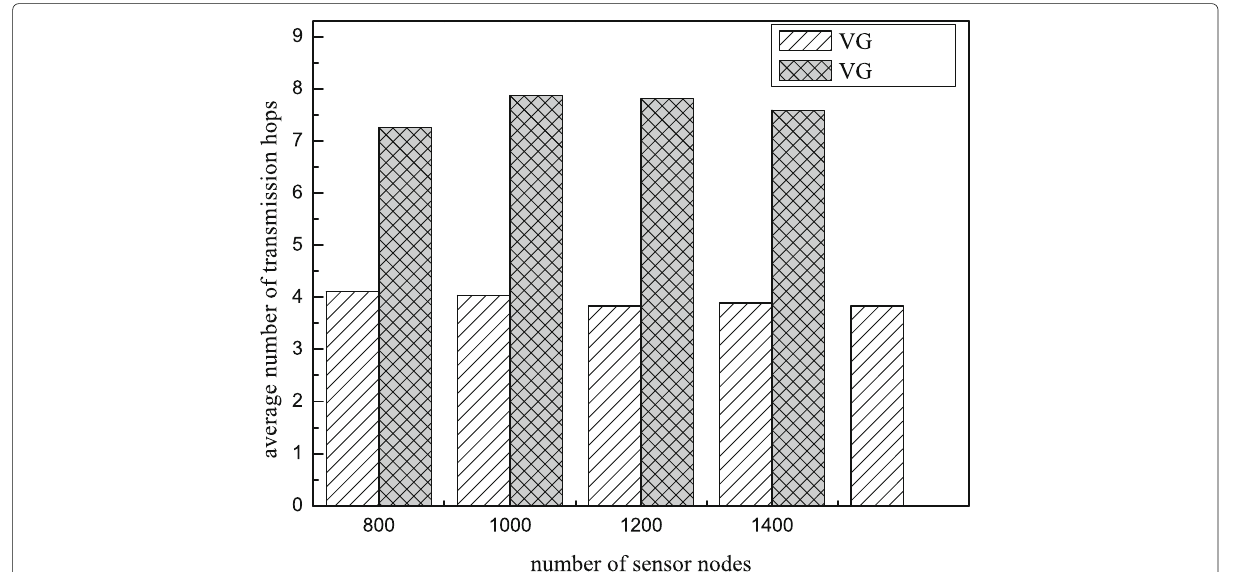
Fig. 15 The comparison of VGDD and VGDCA-C in an average number of transmission hops. The VGDCA-C decreases transmission hops in the applications with centrally distributed